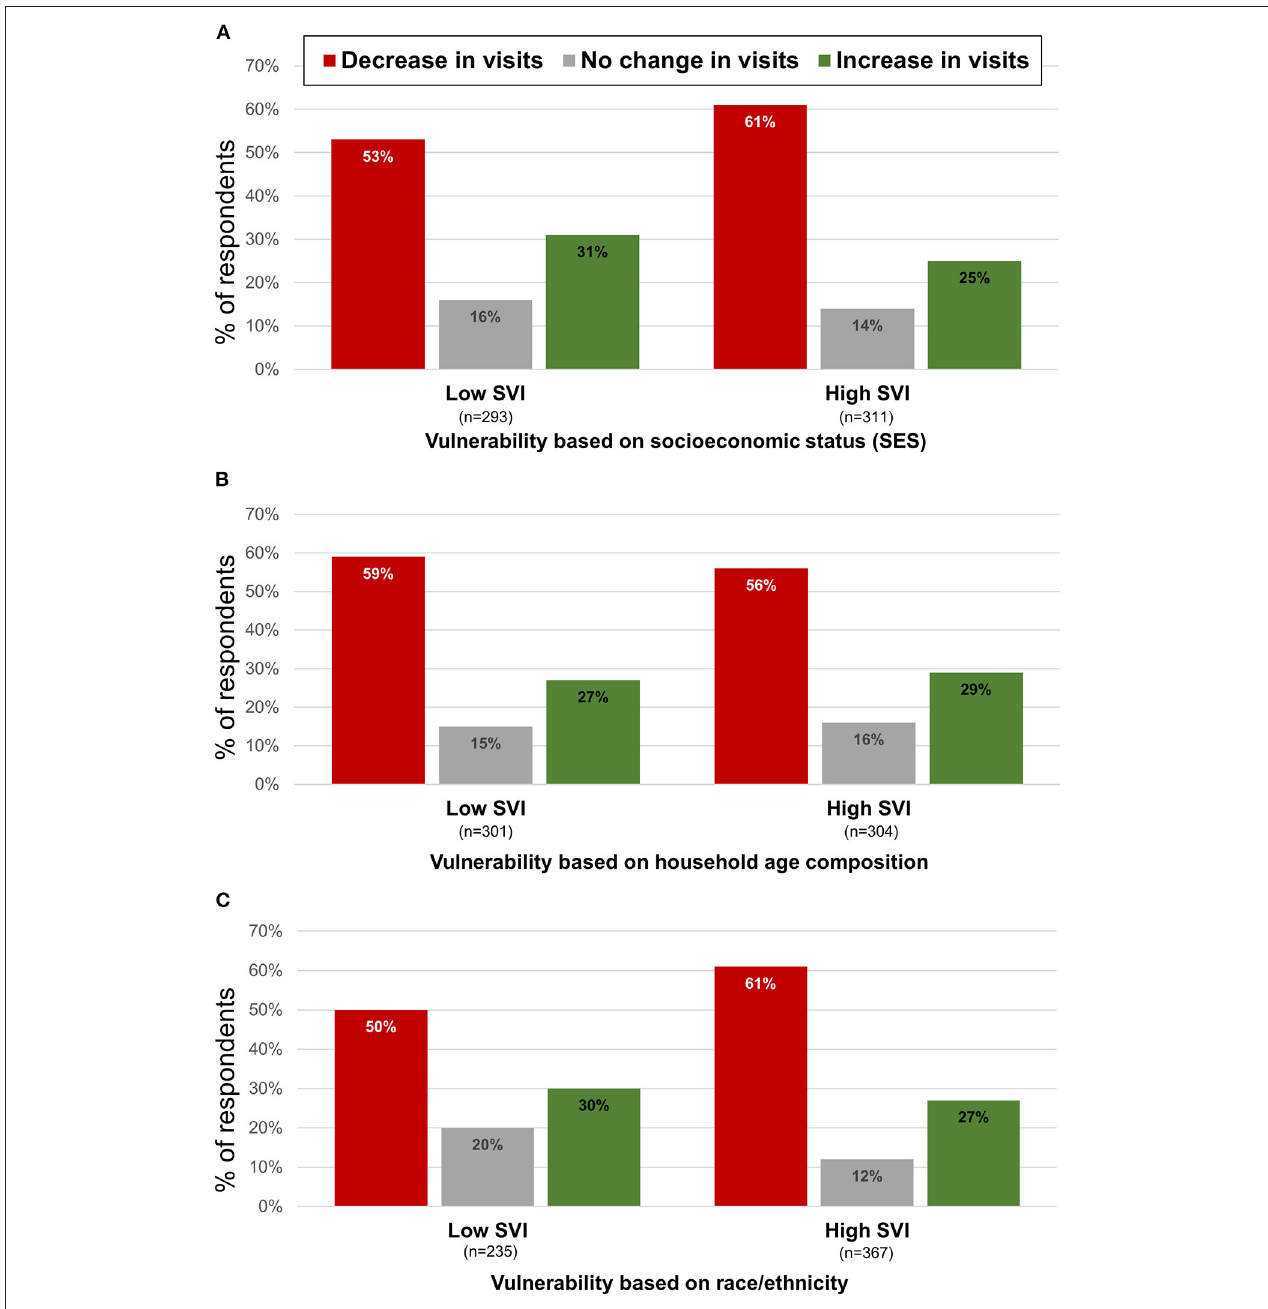
FIGURE 4 | Changes in geo-tracked park visits before (July 2019) and during (July 2020) the COVID-19 pandemic in urban census tracts across the state of North Carolina (NC), USA, based on social vulnerability of communities. Social vulnerability index SVI scores (Flanagan et al., 2011) were coded as low or high based with the midpoint of each index as the cutoff point (e.g., > 2.0 = high vulnerability, < 2.0 = low vulnerability). Park visit changes were grouped into three categories: more than 10% decrease in visits during COVID-19, no change in visits (visits remained within 10% of pre-pandemic levels), and more than 10% increase in visits during COVID-19. Differences are depicted by (A) SVI-SES ( X 2 (2) = 3.9, p = 0.140), (B) SVI-AgeComposition ( X 2 (2) = 0.64, p = 0.728), and (C) SVI-Race ( X 2 (2) = 8.1, p = 0.018). Park visit data are derived from cell phone locations within 605 socio-economically diverse urban census tracts across NC.